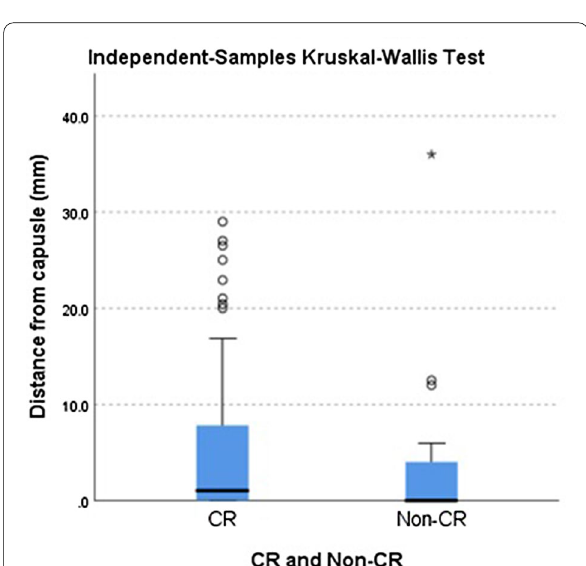
Fig. 7 Box plots of the relationship between the distance from the capsule to the lesion and the CR and non-CR groups, significant difference ( P